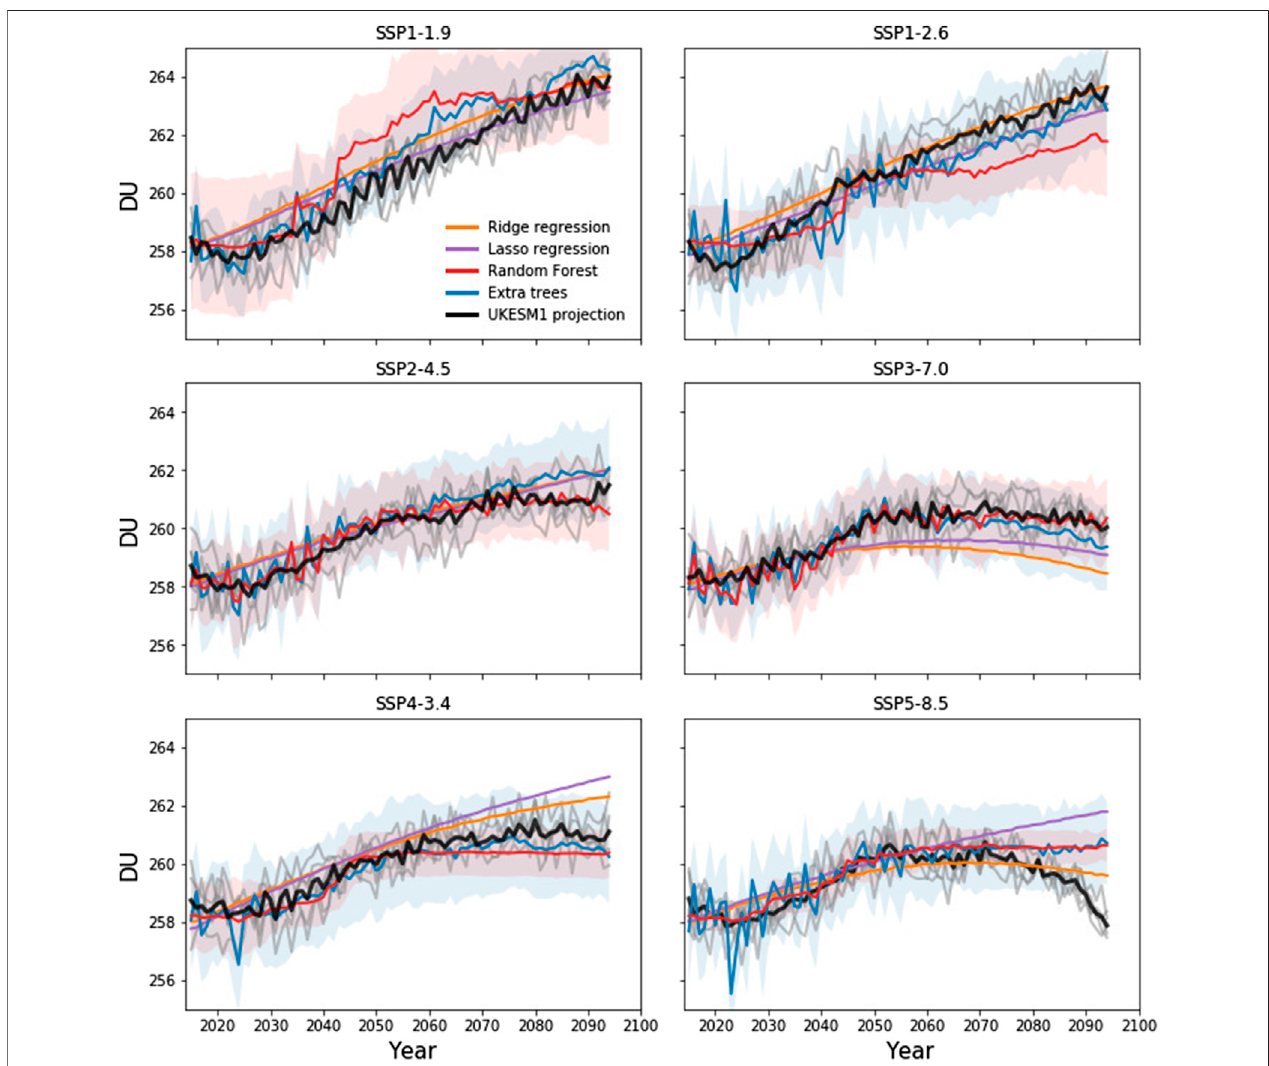
FIGURE 4 | UKESM1 projections of stratospheric column ozone under different Shared Socioeconomic Pathways, averaged over 30 ° S – 30 ° N, for the ensemble mean(black)andindividualensemblemembers(gray),smoothedusingan11-pointboxcarsmoothing.Alsoshownarepredictionsofstratosphericcolumnozonemade using the four machine learning methods assessed in this study (Ridge regression, Lasso regression, Random Forests, Extra Trees). Envelops around the projections made using the Random Forest and Extra Trees methods represent 1 σ uncertainty estimates in those projections, calculated using the in fi nitesimal jackknife method (Wager et al.,